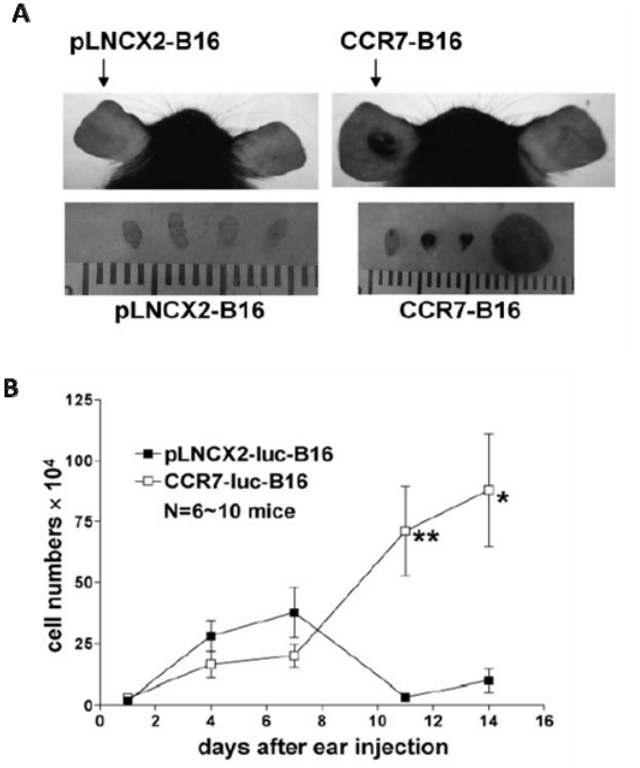
Figure 1. CCR7 facilitated B16 cell tumor formation and lymph node (LN)